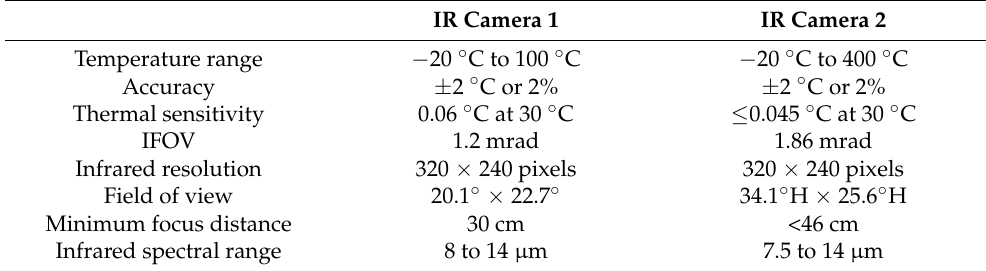
Table 1. IR camera characteristics.